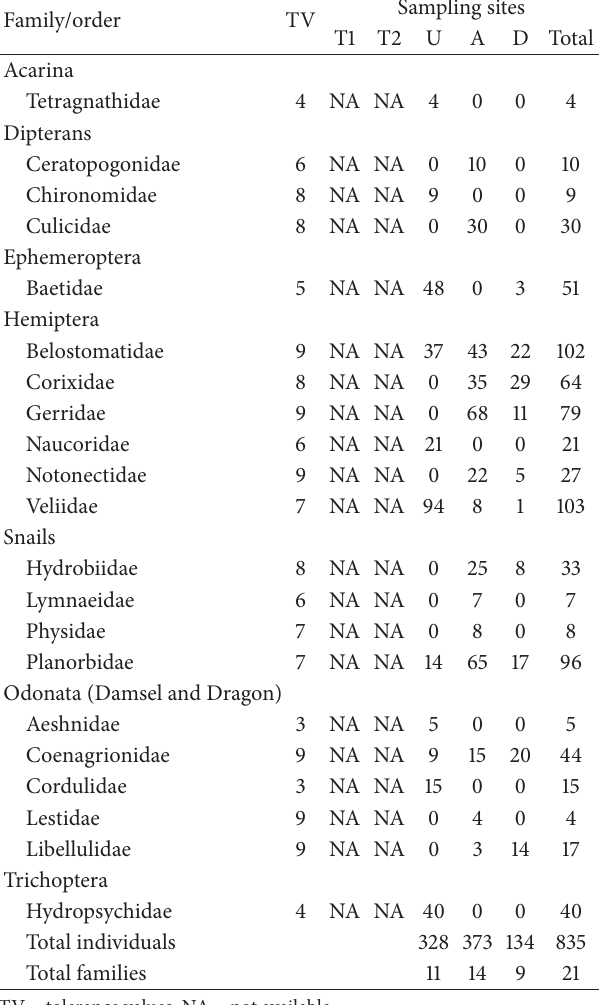
Table 3: Mean values ± std. error of 𝐻 󸀠 , HFBI, and % dipterans at each sampling